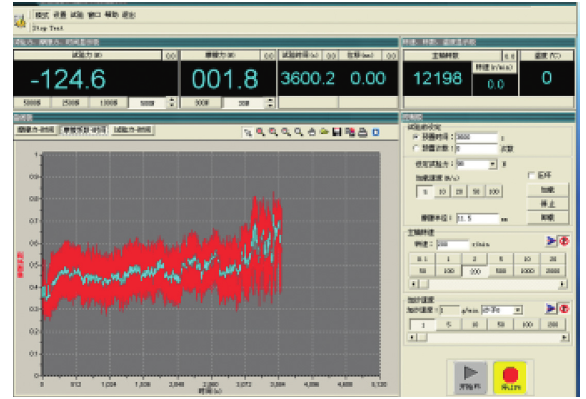
Figure 2: Screen-display of friction and wear machine testing